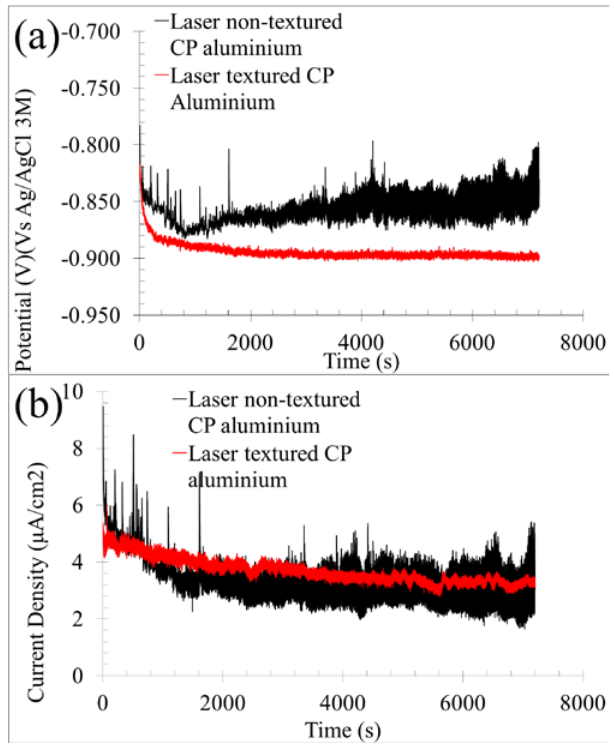
Figure 2. ( a ) AEN results of the non-textured and textured aluminium in 0.6 M NaCl immersion for 2 h, OCP (potential evolution over the time); ( b ) ZRA (current density evolution with the time).